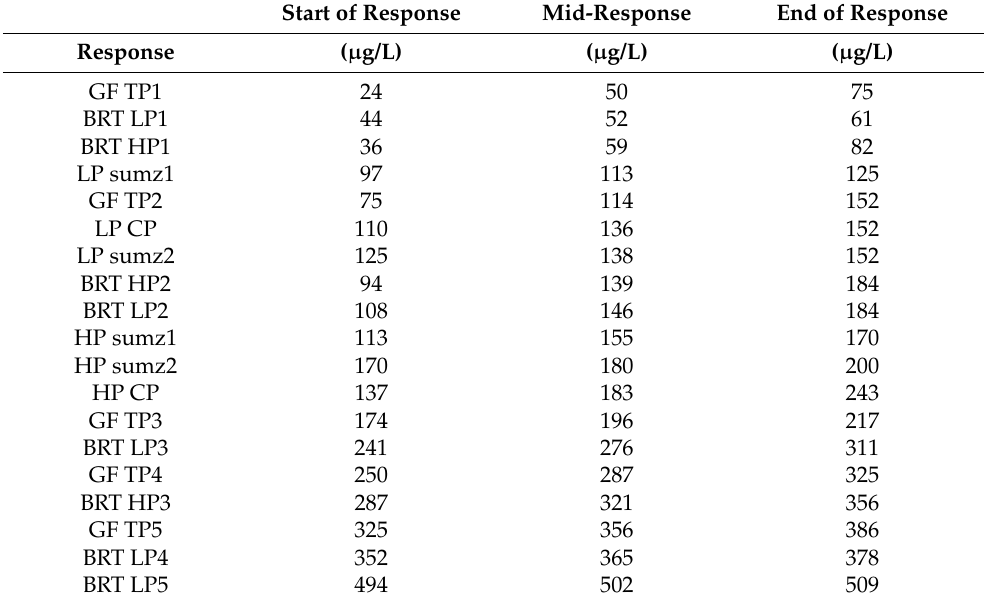
Table 1. Summary of TP responses (Sorted by mid-response). CP is change point (mid-response) for TITAN results with start and end being 5th and 95th percentiles of bootstrapped change points. BRT = boosted regression trees, GF = gradient forest analysis, LP = low phosphorus ASVs, HP = high phosphorus ASVs. The sumZ responses are from TITAN distributions of bootstrapped community change points.